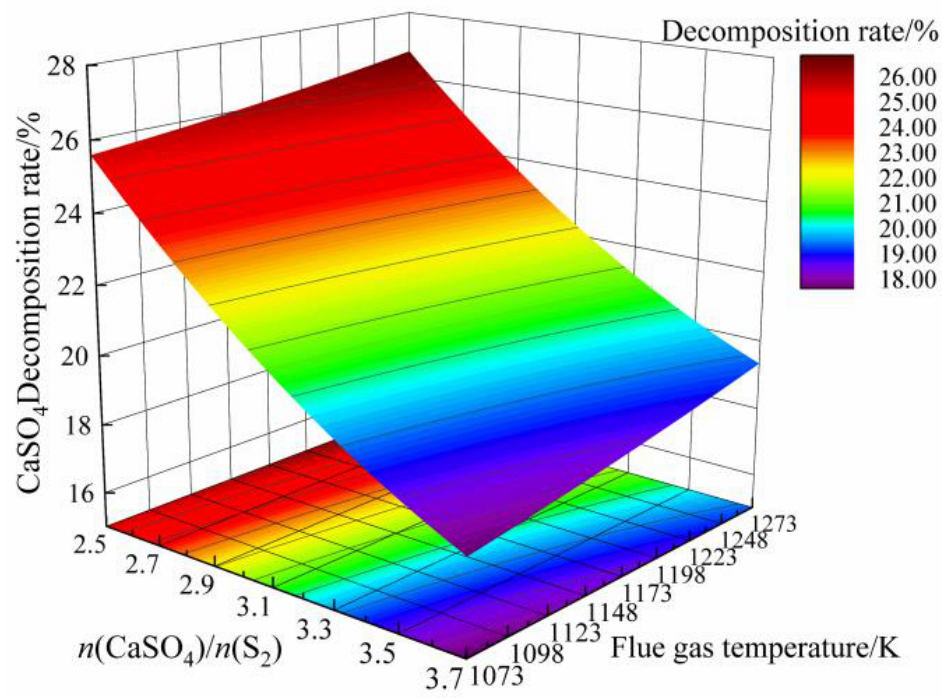
Figure 20. Effect of n (CaSO 4 )/ n (S 2 ) and flue gas temperature on decomposition rate of CaSO 4.